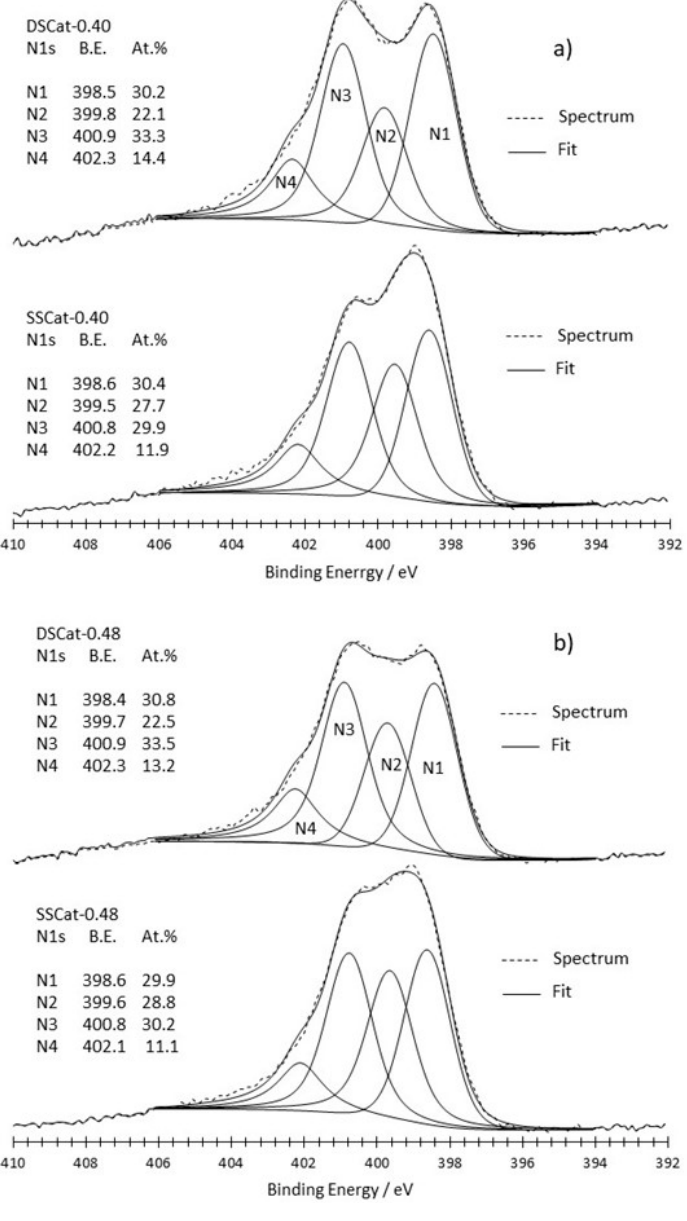
Figure 4. Comparison of N1s peak fitting for SSCat and DSCat catalysts synthesized with ( a ) R = 0.40 and ( b ) R = 0.48.